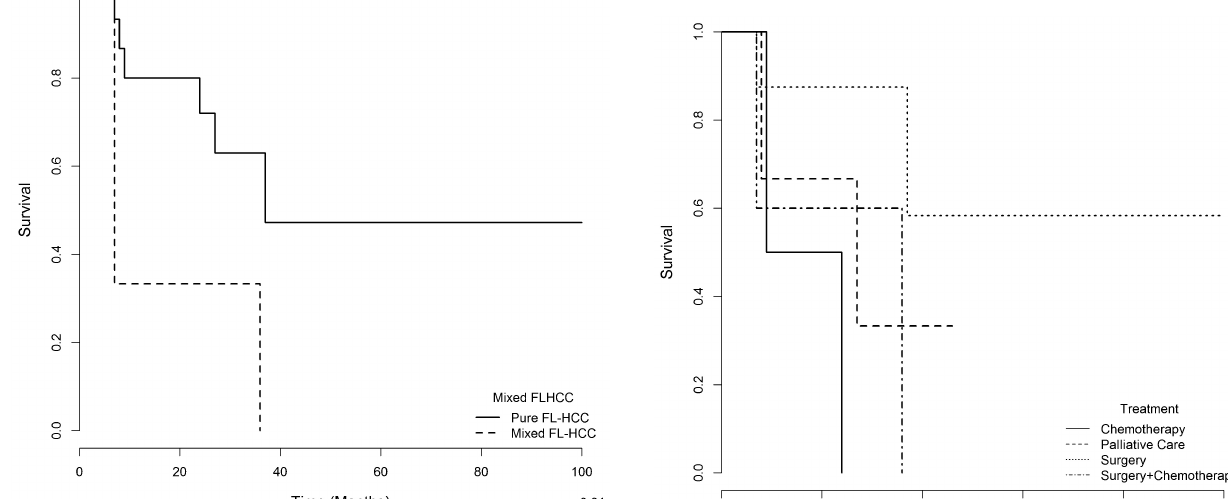
Figure 4 - The overall survival of patients with fibrolamellar hepatocellular carcinoma according to the presence of areas of conventional hepatocellular carcinoma (mixed hepatocellular carcinoma vs. pure fibrolamellar hepatocellular carcinoma).